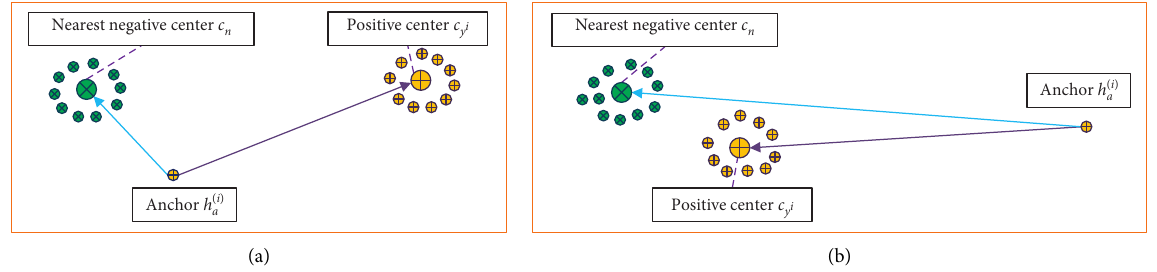
Figure 3: Two cases in TCL. Minimizing TCL can push the anchor to its center in (a) but it cannot in